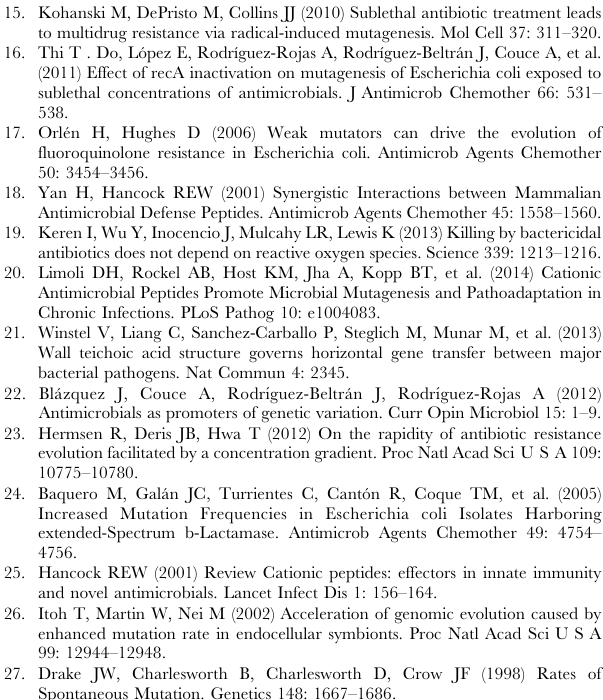
Figure S2 Mutation rates of E. coli MG1655 from cultures with different inoculum sizes. Error bars represent 95% of confidence intervals. Error bars show confidence interval for mutation rate estimation by plating in Rifampicin (100 m g/ml) and using the maximum likelihood method. Figure S3 Killing curves of AMPs and kanamycin in the presence of 100 mM of thiourea. Table S1 MIC and MIC 50 (4 hours) values for E. coli MG1655 for different antibiotics and antimicrobial peptides. Table S2 Primers used for relative gene expression quantification by real time PCR. Table S3 Relative gene expression for E. coli stress response genes in treatments with AMPs and antibiotics vs. non-treated